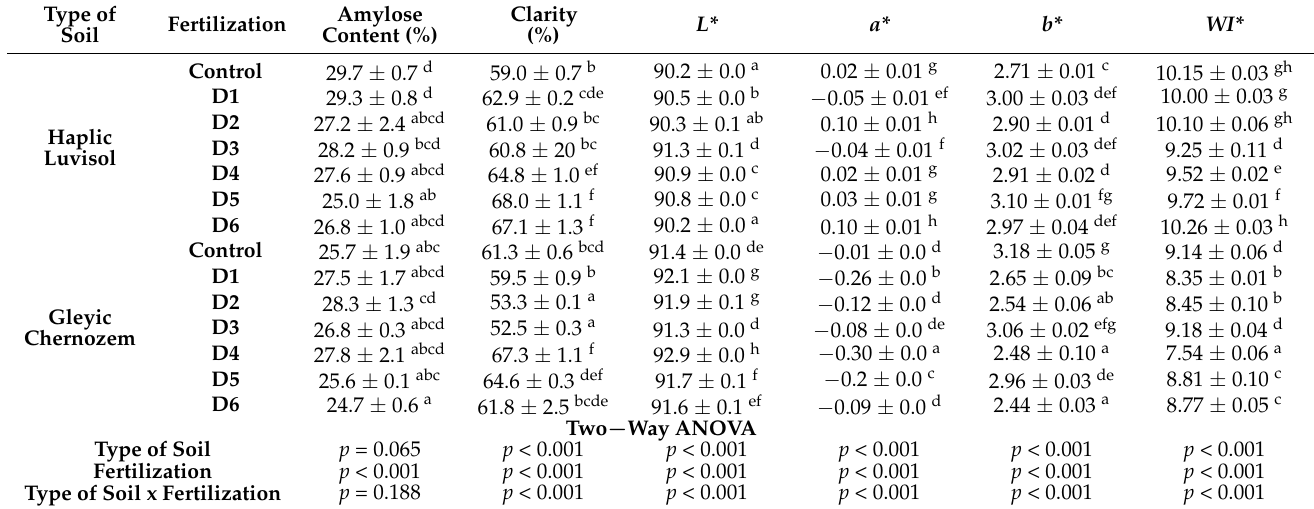
Table 1. Amylose content, clarity of pastes, and color of the